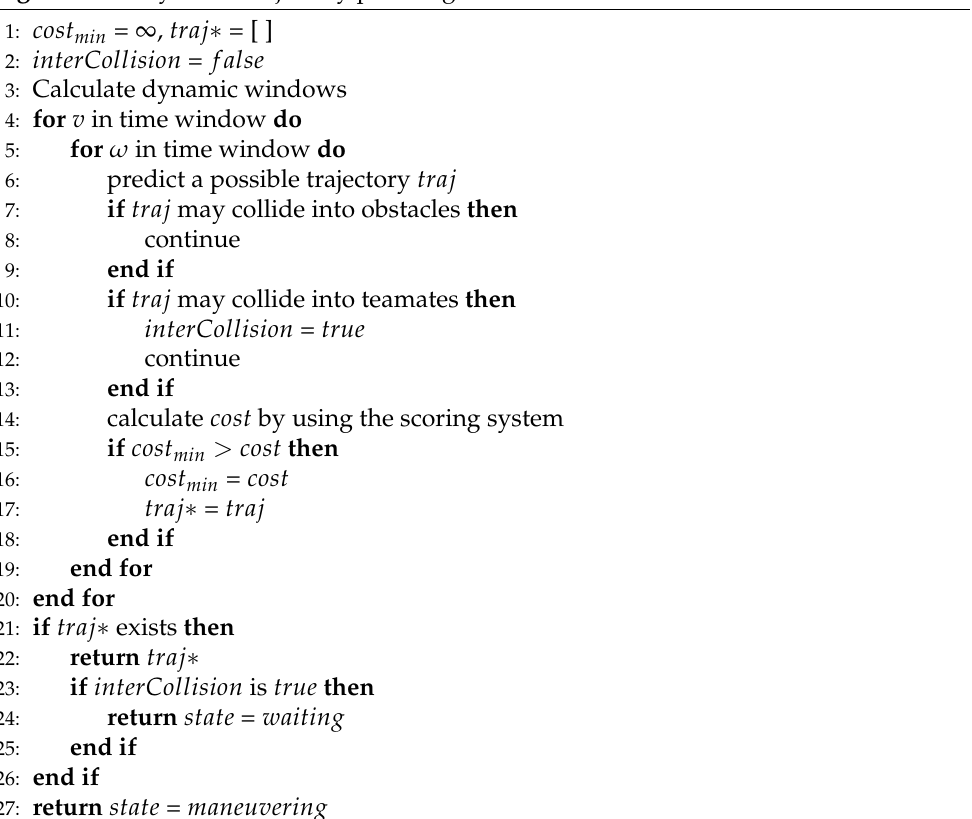
Algorithm 3 Dynamic trajectory